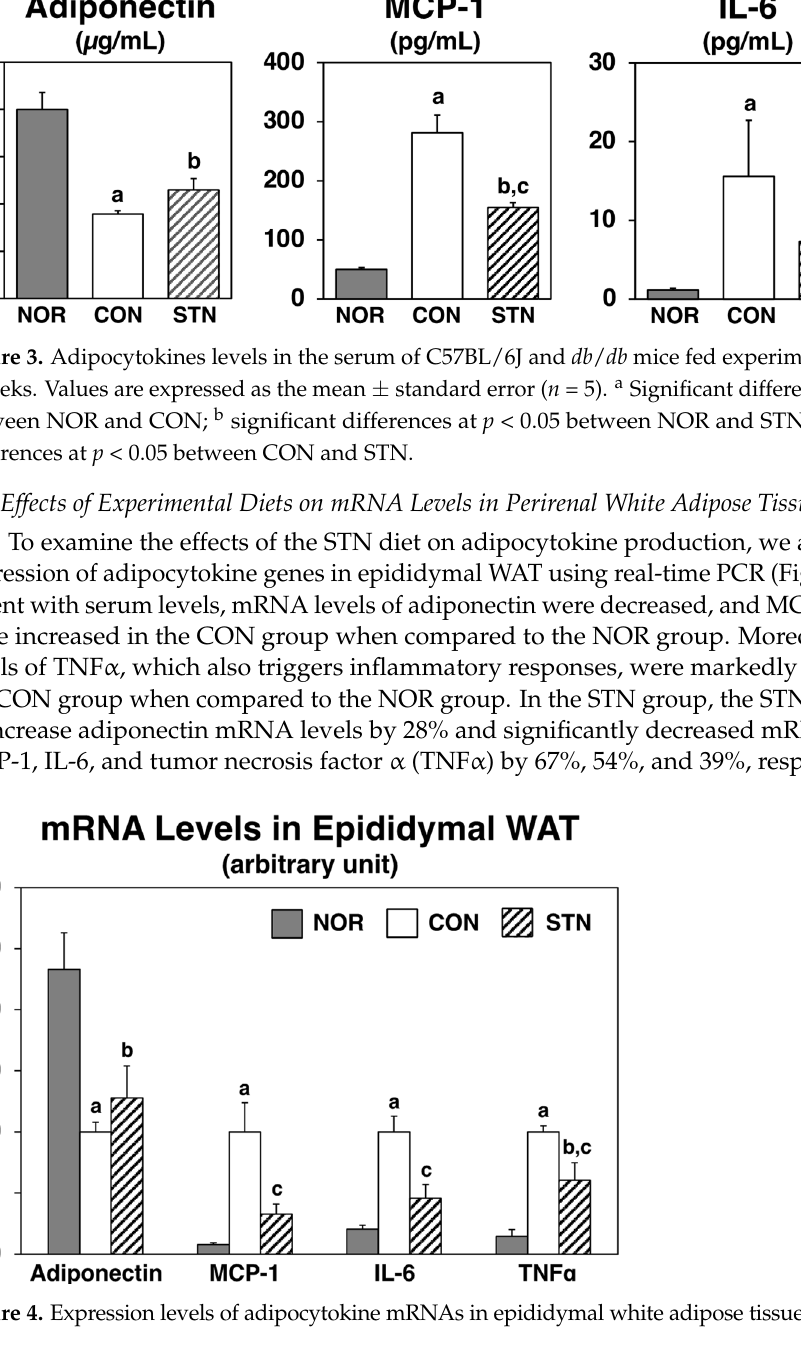
Figure 2. Glucose and insulin levels in the serum of C57BL/6J and db/db mice fed experimental diets for 4 weeks. Values are expressed as the mean ± standard error ( n = 5). a Significant difference at p < 0.05 between NOR and CON; b significant differences at p < 0.05 between NOR and STN; c significant differences at p < 0.05 between CON and STN.